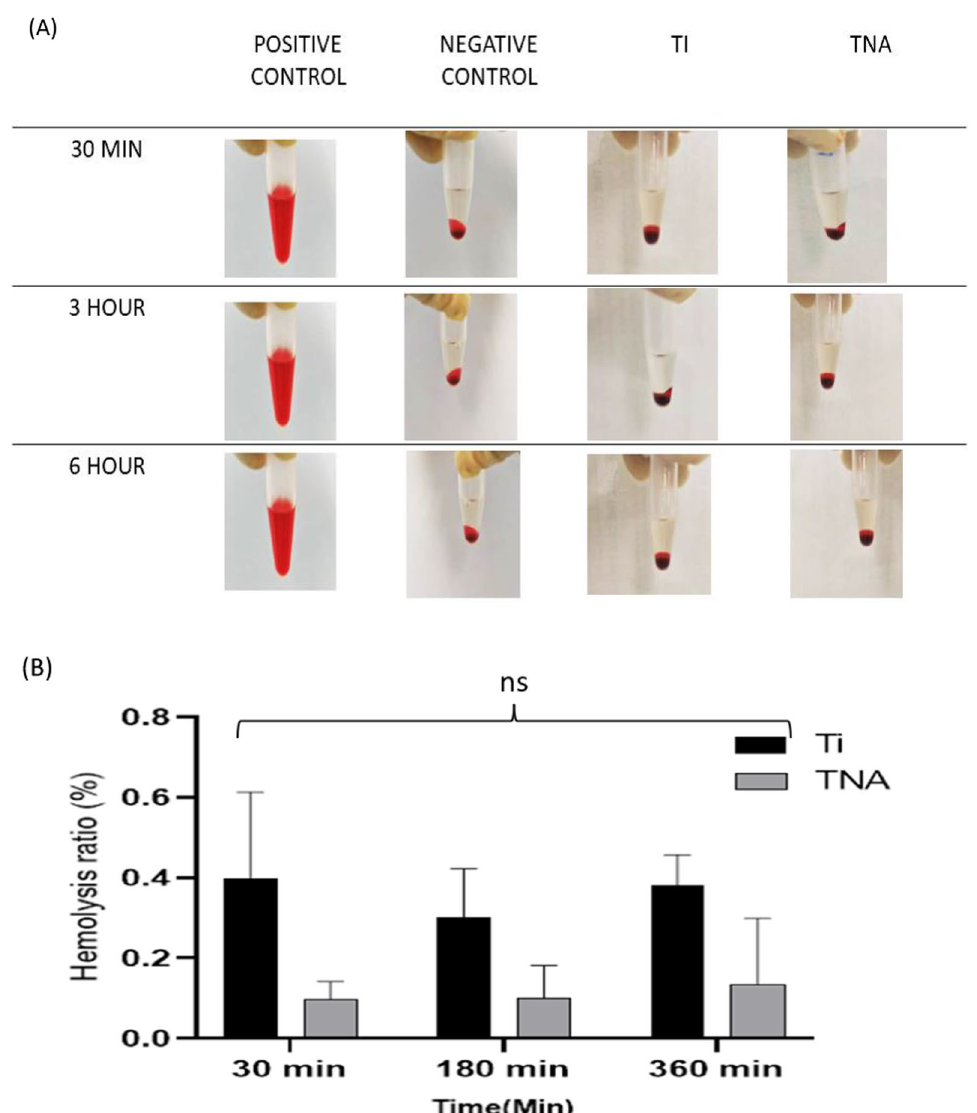
Fig. 4 A Haemolytic assay of Ti and TNA surfaces. Image of samples after the centrifugation at 2500 rpm for 5 min. The presence of haemolysis in the supernatant is only observed in the positive control tube. B Haemolysis ratio profile of Ti and TNA surfaces. Results indicate there is no significant differences in all the period tested which is 30, 180 and 360 min which compared for both material surfaces (Ti and TNA) where the p -value is > 0.05. The error bar represents mean standard deviation in triplicate within three ±